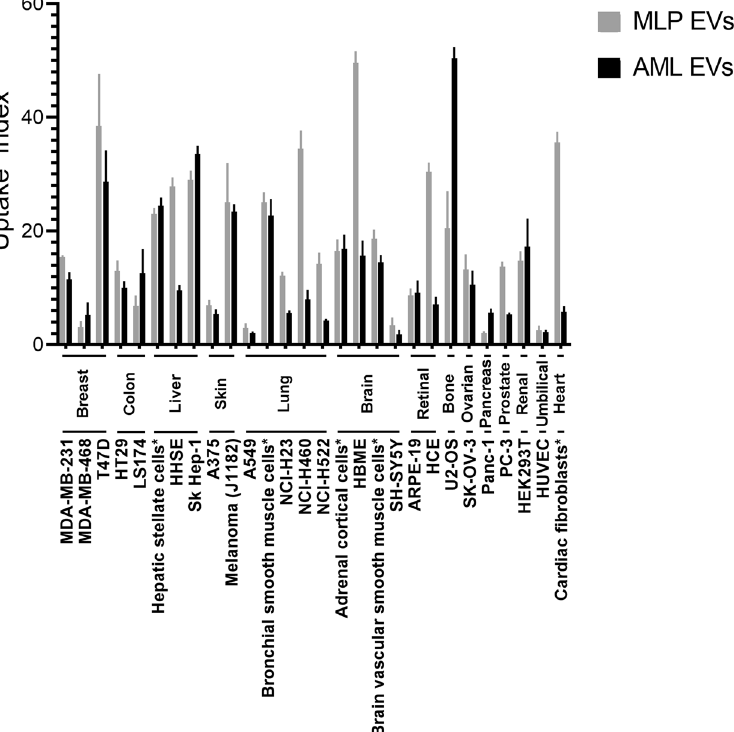
Figure 7. High-content uptake analysis of native EVs incubated with a panel of 28 different human cell lines. Uptake index is determined as the fold-change in fluorescence compared to a DiI background control after a 16 hour incubation, with uptake index of the DiI background thus set to ‘1’ for each cell line. Cell lines are broadly clustered by organ type and lines marked with * are primary